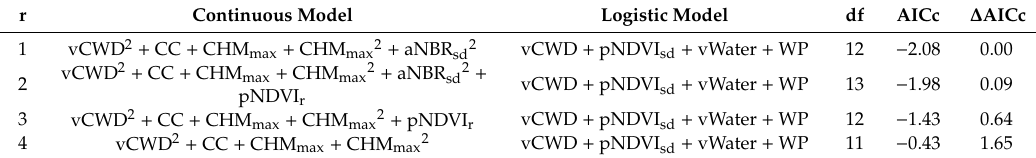
Table 3. Candidate two-part models for coarse woody debris (CWD) volume according to small sample Akaike information criterion (AICc). The rank (r), degrees of freedom (df) and delta AICc ( ∆ AICc) are provided for each model. The following variables were selected in all continuous models: area of detected CWD objects via image-analysis (vCWD); canopy closure (CC); and height of the tallest tree (CHM max ). The following were selected in some continuous models: standard deviation of the active normalized burn ratio (aNBR sd ) and range of passive NDVI (pNDVI r ). Finally, all logistic models included: vCWD, standard deviation of passive NDVI (pNDVI sd ), visible water area (vWater) and wetland probability (WP).